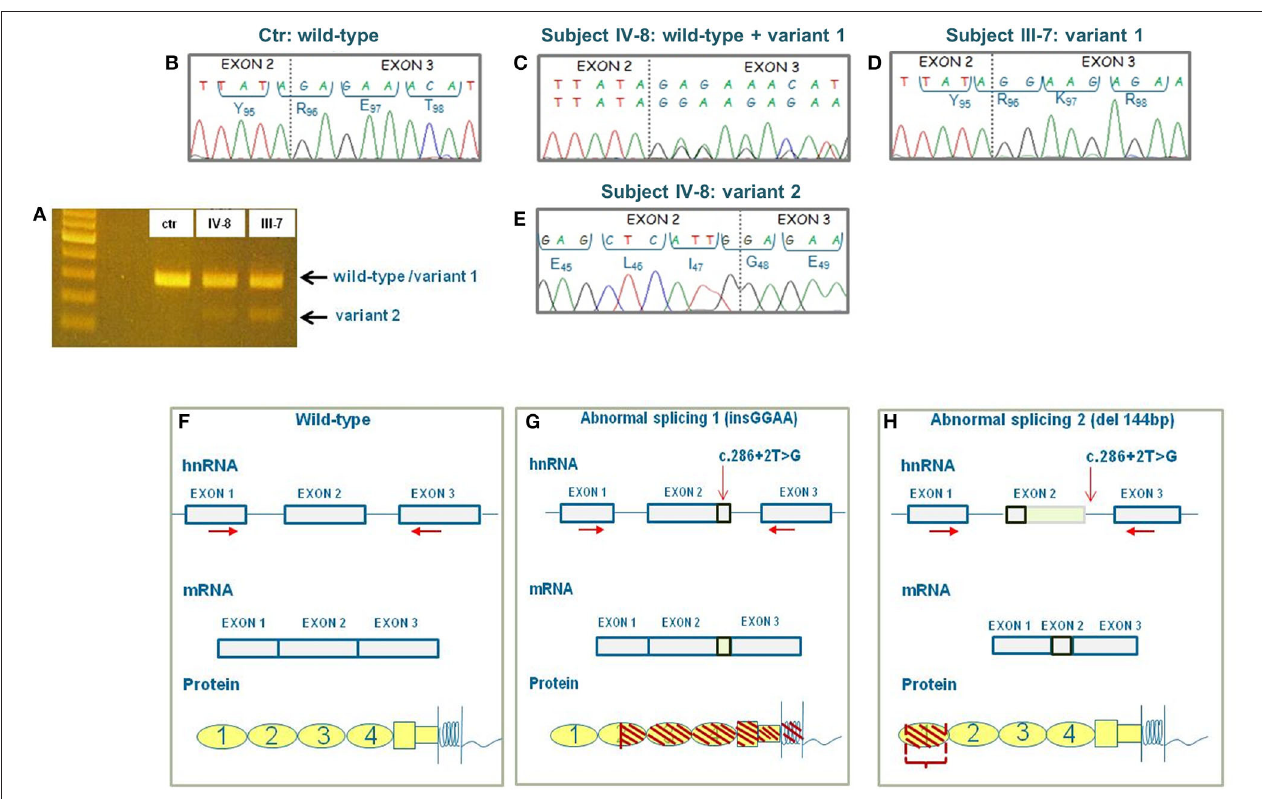
FIGURE 3 | Results of CD46 cDNA sequencing and prediction of the effect of the abnormal splicings at protein level. (A) Agarose gel image of cDNA showing a single band in the control (ctr) and two bands in the proband (IV-8) and in his healthy father (III-7). First lane: 100-bp ladder used as a size marker. (B) Electropherogram showing the wild-type cDNA sequence of the control. (C) Electropherogram of the upper band in the proband (subject IV-8) showing the wild-type sequence and the variant 1’s sequence with 4-bp insertion. (D) Electropherogram of the upper band in the homozygous proband’s father (subject III-7) showing the sequence of variant 1 only. (E) Electropherogram of the lower minor band in the proband showing the sequence of variant 2 with the deletion of 144 bp. (F) Wild-type CD46 heterogeneous nuclear RNA (hnRNA), messenger RNA (mRNA), and protein. (G) Representation of the effect of splicing variant 1 on CD46 hnRNA, mRNA and protein. The predicted protein is truncated in the SCR2 domain and includes only the first 128 amino acids. (H) Representation of the effect of splicing variant 2 on CD46 hnRNA, mRNA, and protein. The predicted protein lacks 48 amino acids of SCR1. Horizontal red arrows indicate the localization of primers used for cDNA sequencing. The vertical red arrow indicates the localization of c.286 + 2T > G variant.